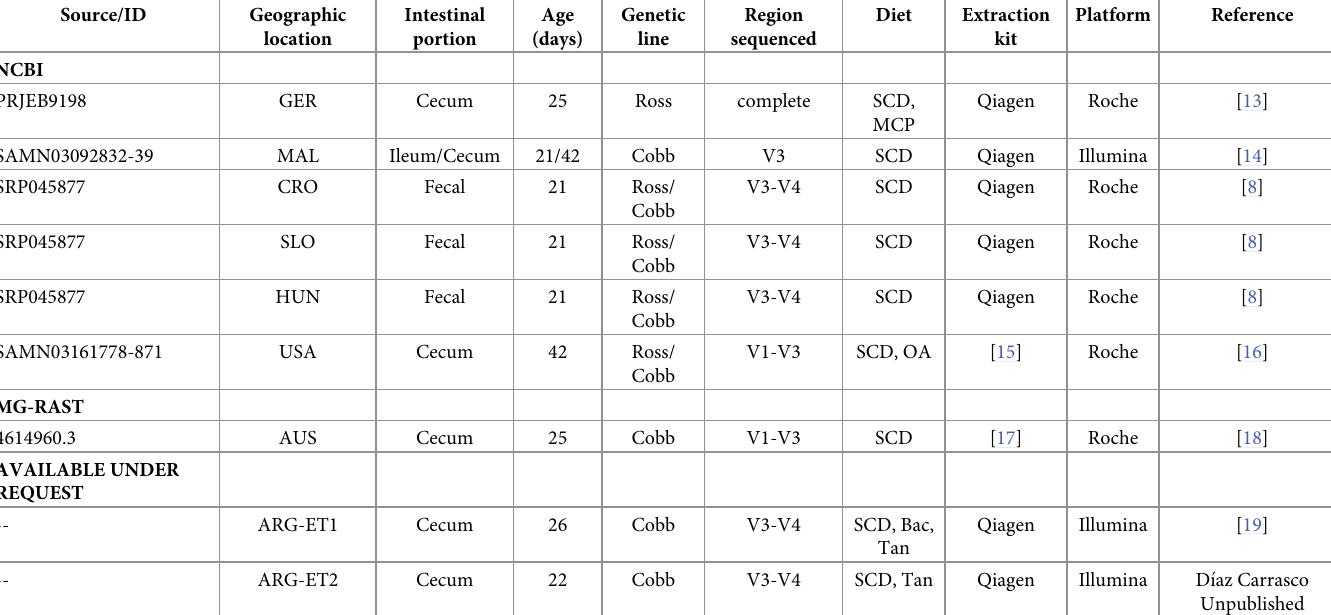
Table 1. 16S rRNA gene amplicon data used to compare the chicken GIT microbial composition throughout geographic